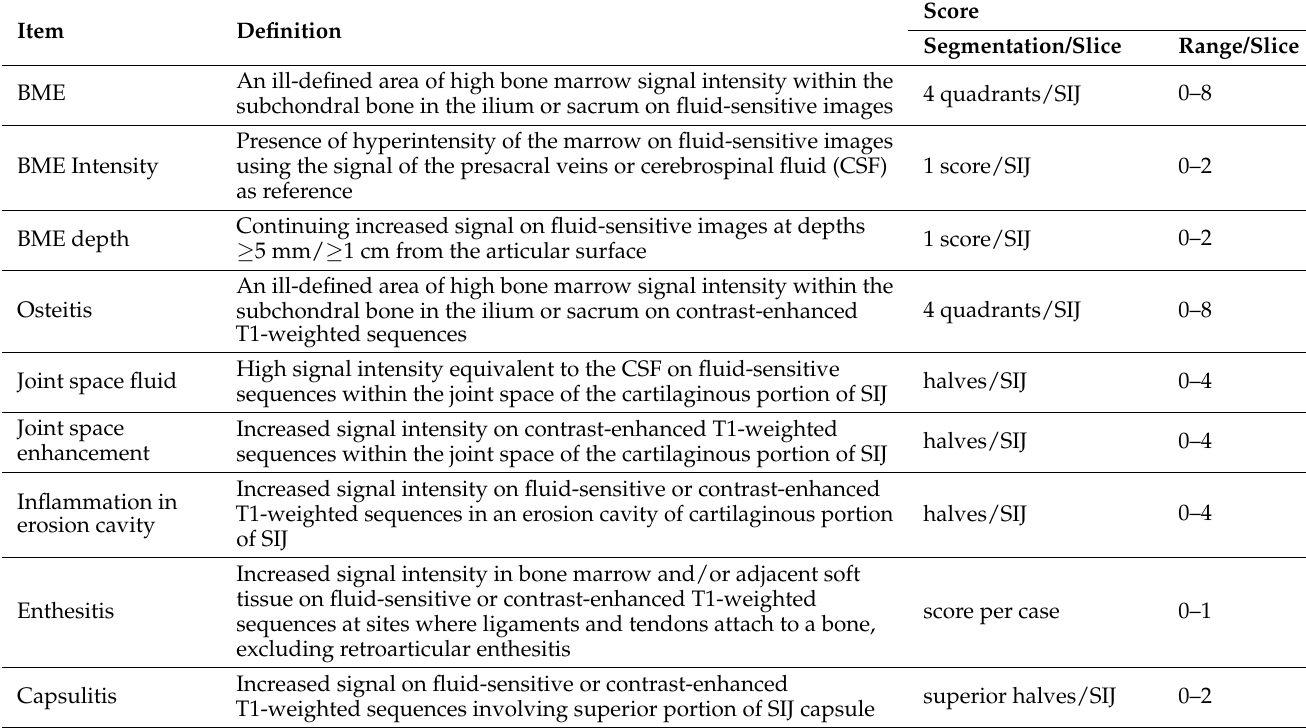
Table 2. Scoring system for assessing active inflammation of the sacroiliac joint by MRI according to the JAMRIS-SIJ scoring system.